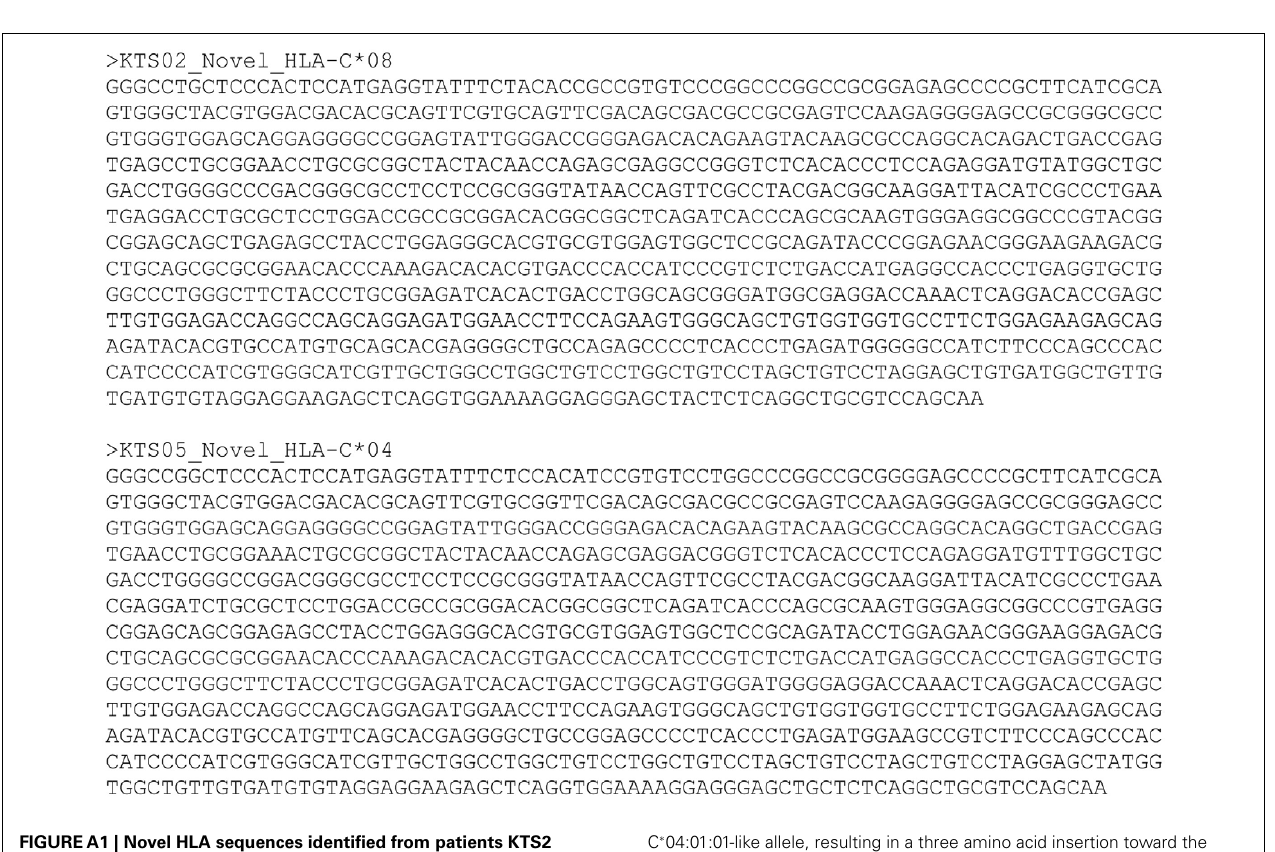
FIGUREA1 | Novel HLA sequences identified from patients KTS2 and KTS5. HLA RNA pyrosequencing identified two novel HLA-C sequences in the patient cohort. KTS2 presented a novel C ∗ 08:22-like allele with aT587C mutation, resulting in a leucine to proline substitution. KTS5 presented a putative 9bp insertion at position 974 in a